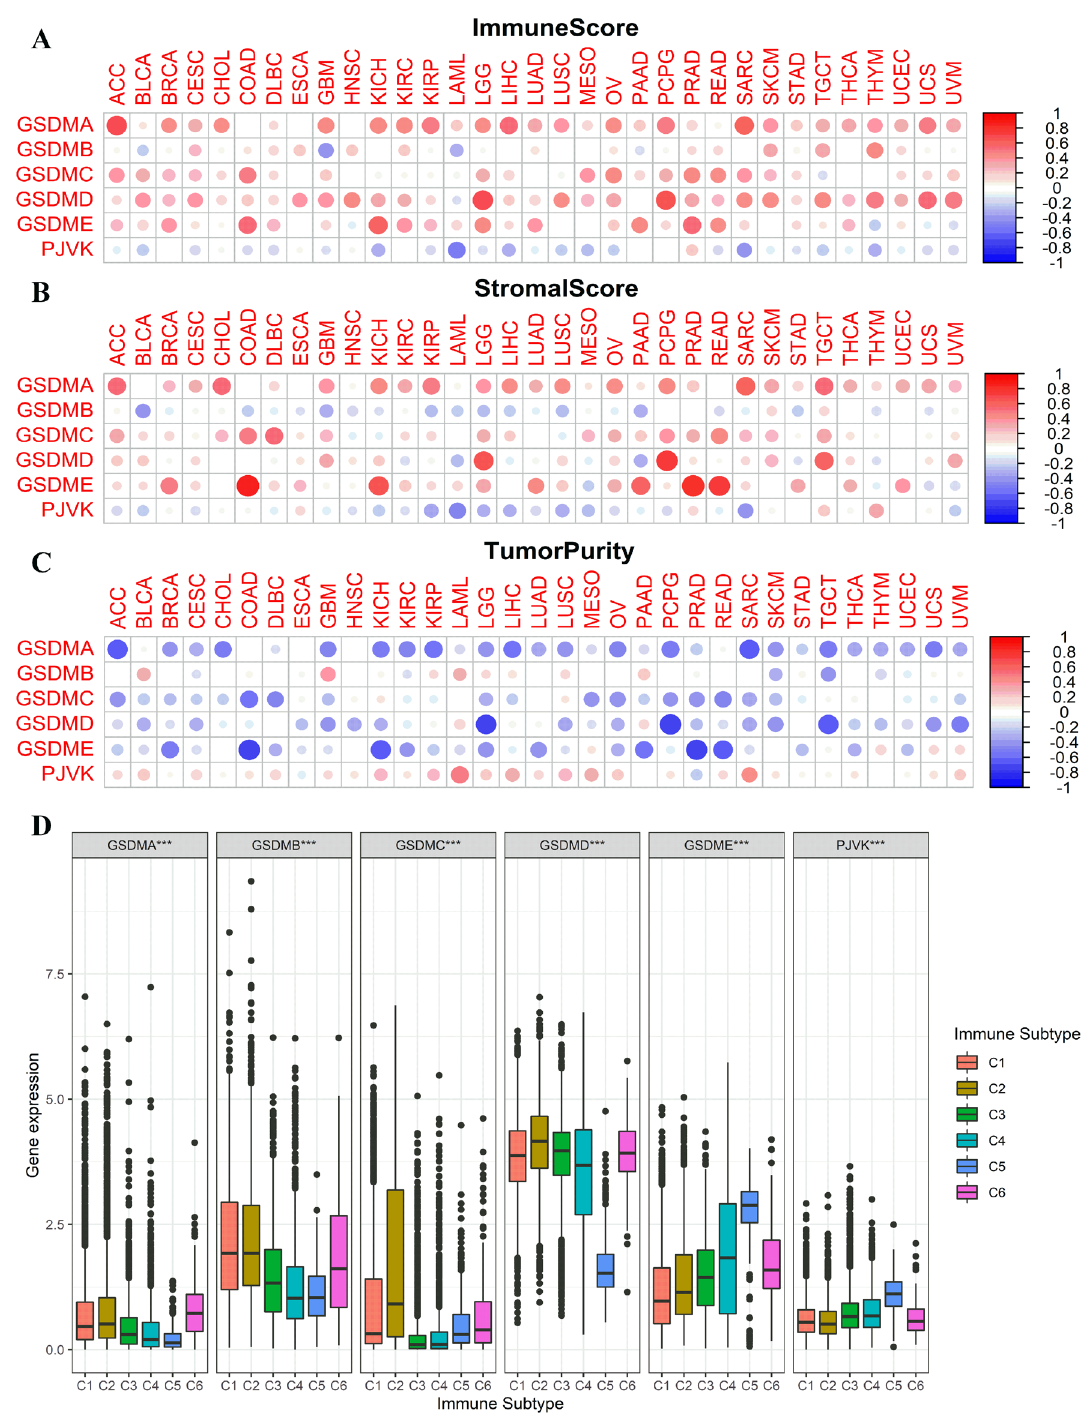
Figure 7. Associations of the gasdermin family gene expression with tumor microenvironment and immune infiltrate subtypes in pan-cancer. Correlation matrix plots showing the associations of gasdermin family gene expression with the immune score ( A ), stromal score ( B ), and tumor purity ( C ) of all the cancers; The size of the dots represented the absolute value of the correlation coefficients; The bigger the size is, the stronger the correlation would be; The red and blue represented the positive or negative correlation, respectively. Correlations of gasdermin family genes expression with immune infiltrate sub-types in all the malignancies ( D ); P < 0.050, P < 0.010, and P < 0.001were denoted by “*”, “**”, and “***”,